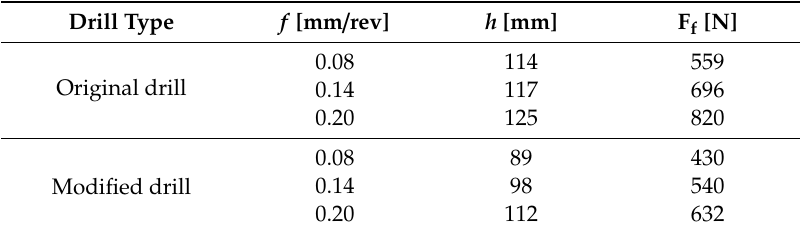
Table 7. Burr height and axial force value depending on the type of drill